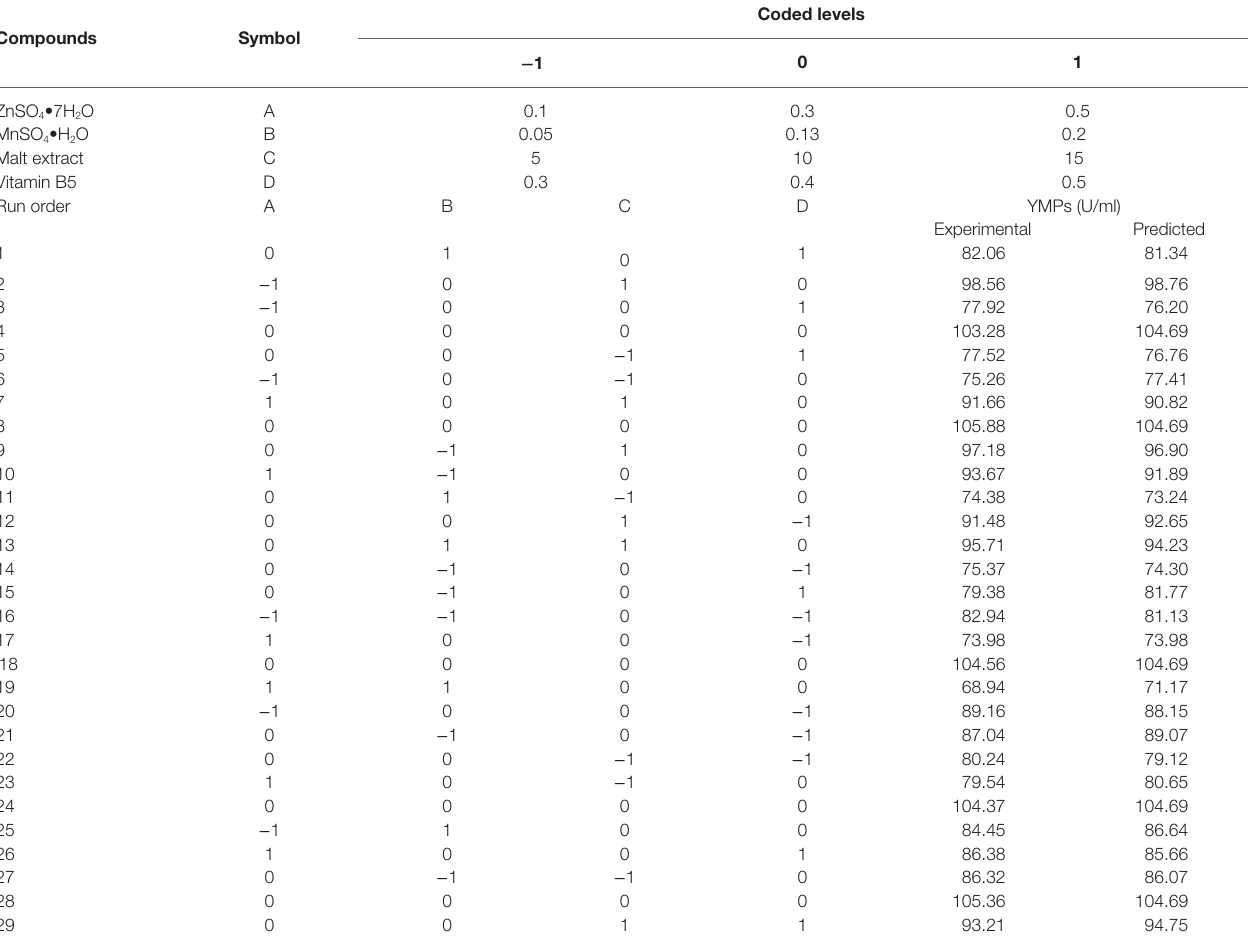
TABLE 2 | Box–Behnken design for process parameters of yellow monascus pigments production by M. purpureus H14 in submerged fermentation for 10 days.